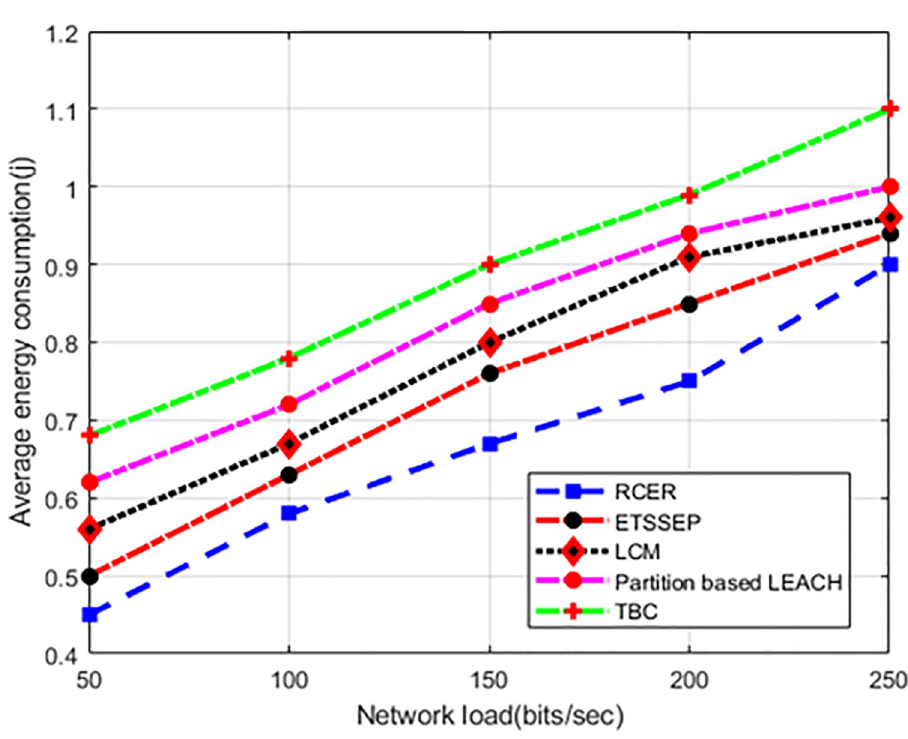
Fig 11. Energy consumption in varying network